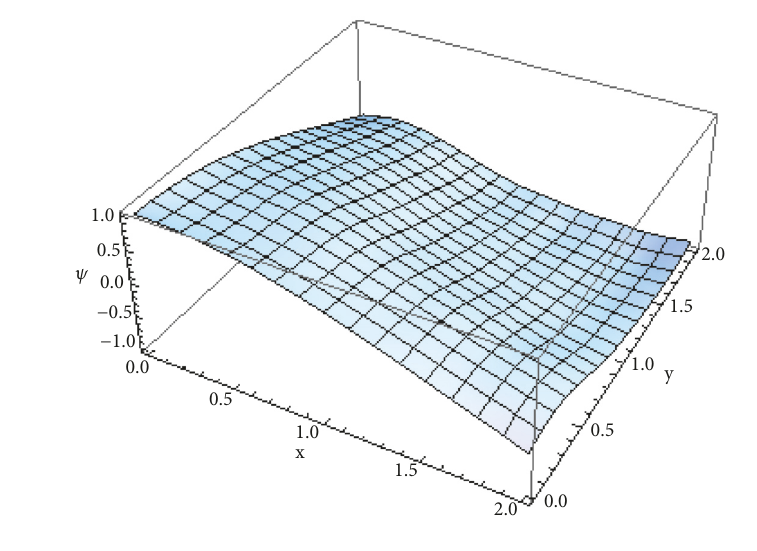
Figure 6: Real solution of the two-dimensional wave function obtained by